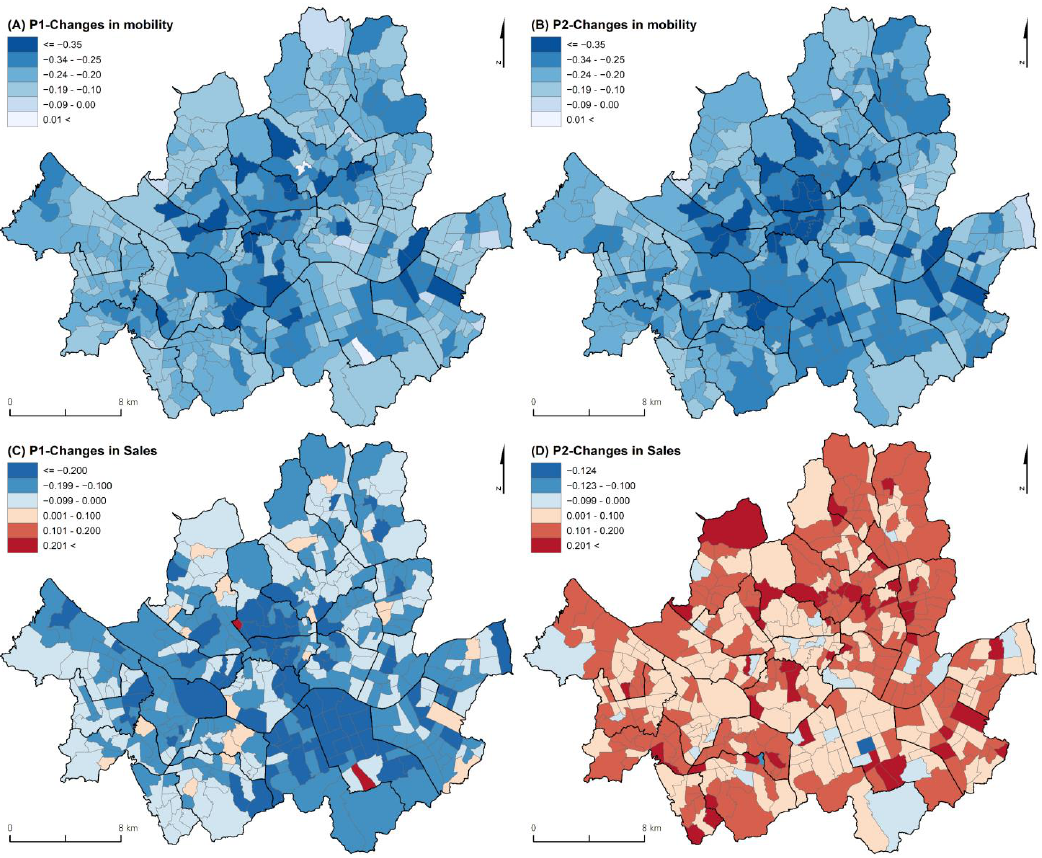
Figure 3. Spatial distributions of the changes in population mobility and restaurant sales; the change in population mobility for P1 ( A ) and for P2 ( B ), and the change in restaurant sales for P1 ( C ) and for P2 ( D ).